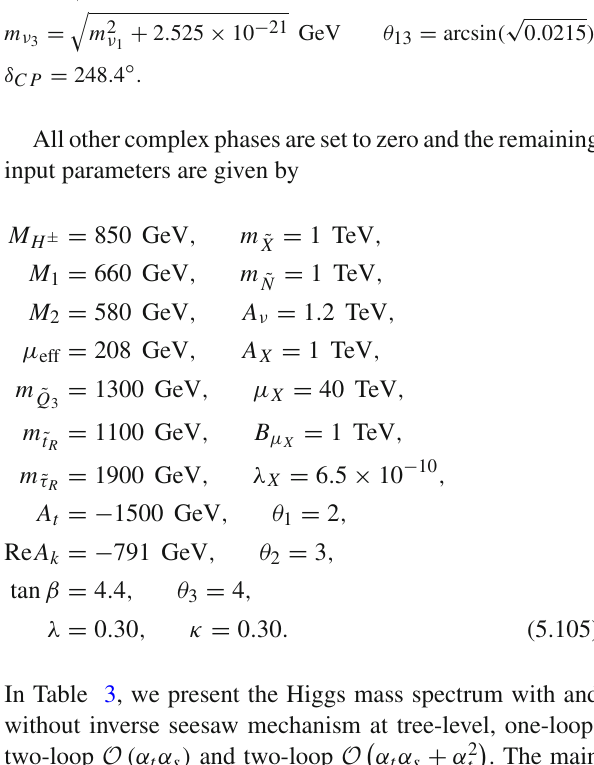
Table 2 Scan ranges for the random scan over the NMSSM parameter space Parameter Scan